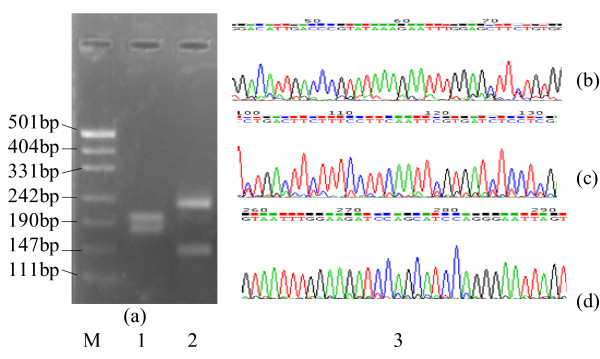
HBV core gene RFLP pattern C'(M. DNA marker;1. RFLP E;2. RFLP C' 3. Cleavage site of Tsp509I were found at position 61(b),116(c),261 and 286(d) corresponding to nucleotide 110,165,310 and 335 in HBV core gene showing RFLP C', respectively).